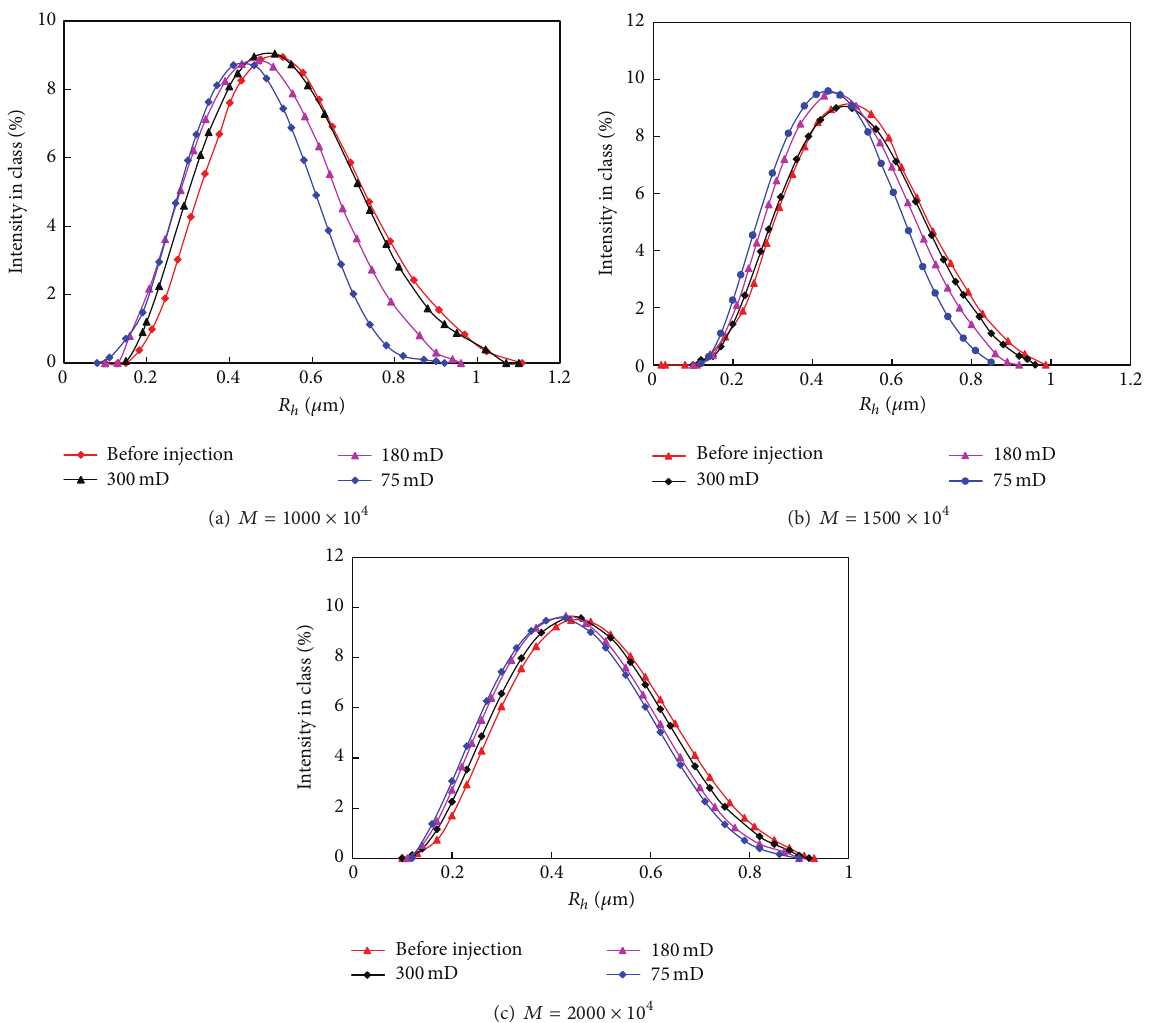
Figure 3: 𝑅 ℎ distribution of polymer solution with different relative molecular mass before and after injection of different permeability cores.